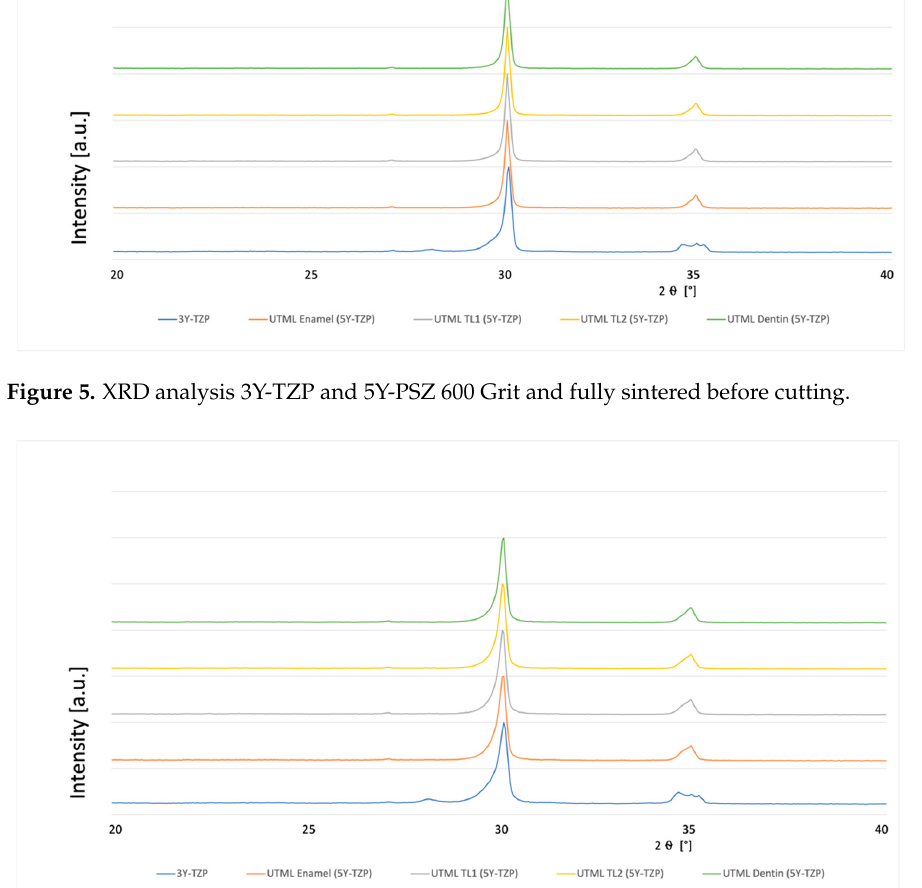
Figure 6. XRD analysis 3Y-TZP and 5Y-PSZ air abraded with alumina particles 50 µ m and fully sintered before cutting.